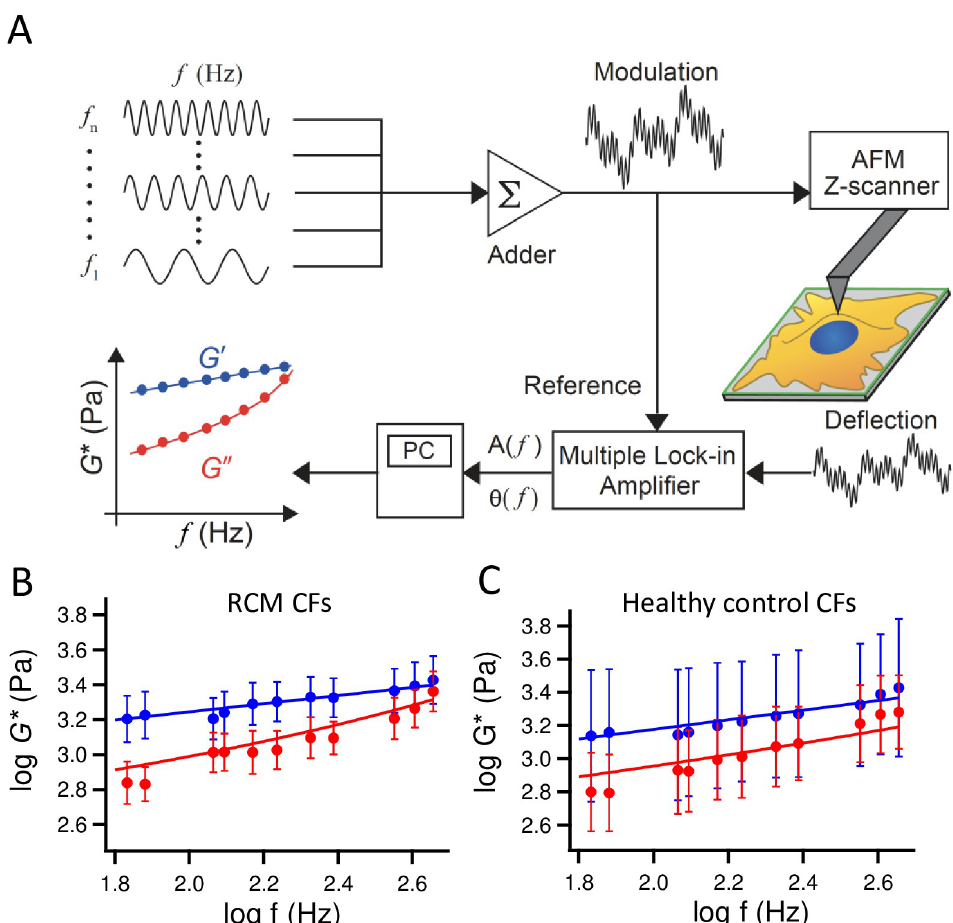
Fig 1. Frequency-domain AFM measurement of cardiac fibroblasts (CFs). (A) Modulated voltages with n frequencies from f = f 1 to f n were added and applied to the z-scanner to oscillate the cantilever. The amplitude A ( f ) and phase shift θ ( f ) of the cantilever deflection signal at each frequency during the indentation were calculated with a multiple lock-in amplifier program and used to estimate the storage G’ and loss G” moduli as a function of f at each measurement position. The frequency dependences of geometric mean and standard deviation of G’ and G” of all cells derived from three patients with RCM (B, n = 165 cells) and three healthy controls (C, n = 63 cells). Solid lines represent the fitted results to Eq